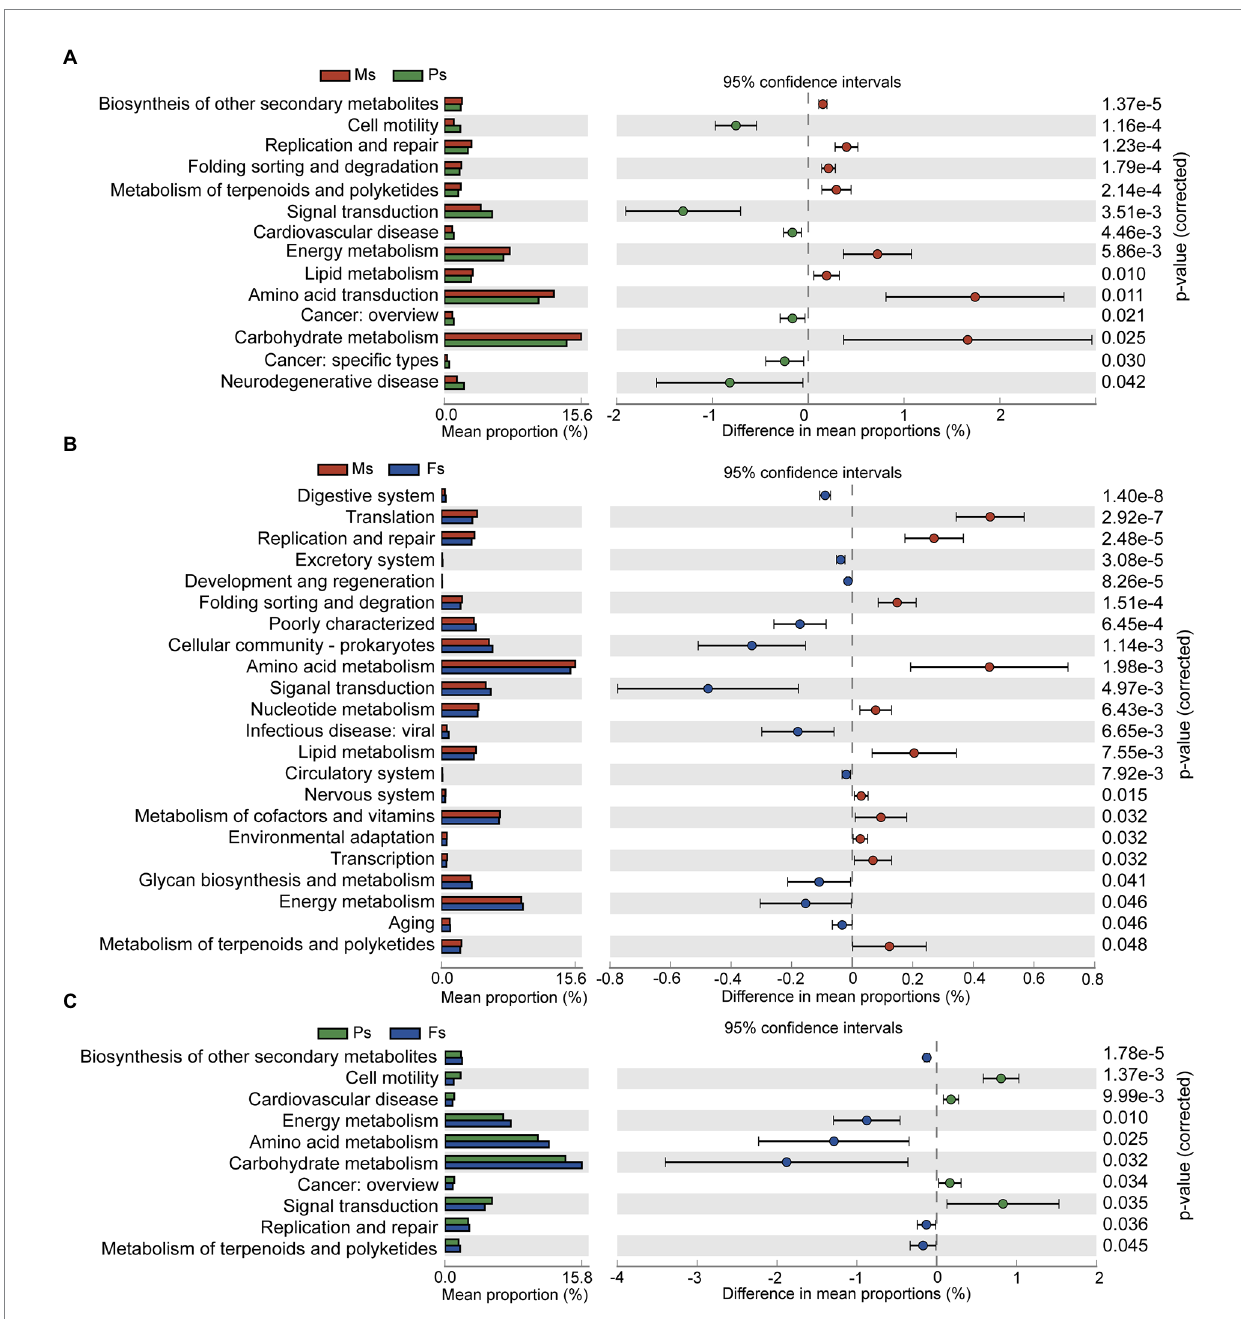
FIGURE 6 Variations in KEGG functions of the soil microbiome during mycelium, primordium, and fruiting body stages of Morchella sextelata . (A–C) Comparisons of mycelium and primordium stages (A) , mycelium and fruiting body stages (B) , and primordium and fruiting body stages (C) . Ms, mycelium stage; Ps, primordium stage; Fs, fruiting body